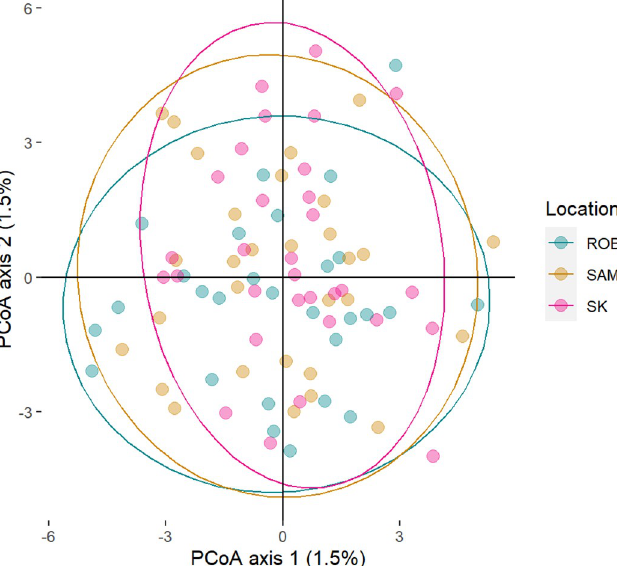
Fig 2. Principal coordinate analysis (PCoA) performed with sea urchin C . sylviae data obtained from Robinson Island (ROB), San Ambrosio Island (SAM), and Selkirk Island (SK).